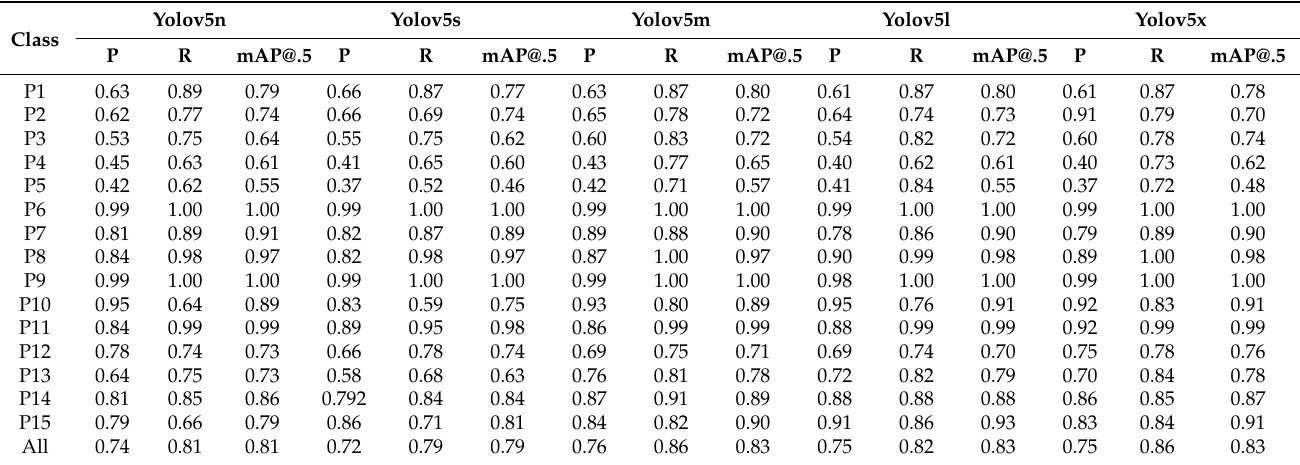
Table 3. Training Performance of Yolov5